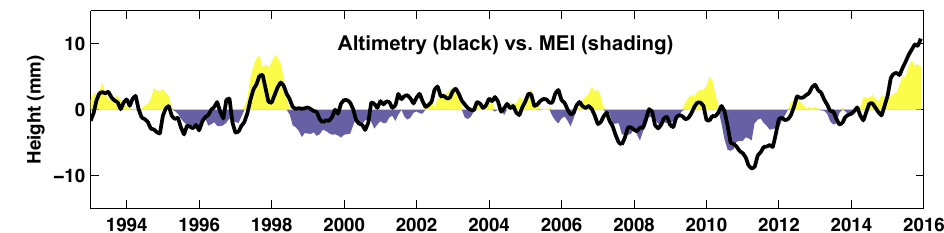
Figure 6. Nonseasonal anomalies of GMSL (black) and MEI (shading) over